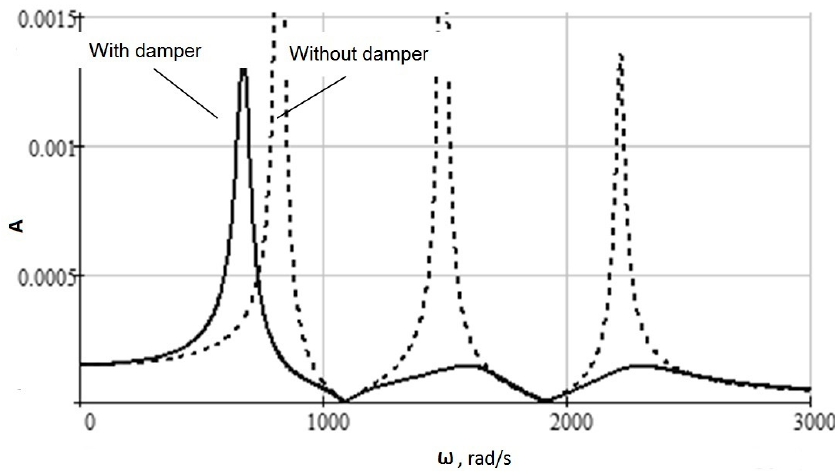
Figure 7. Frequency response.